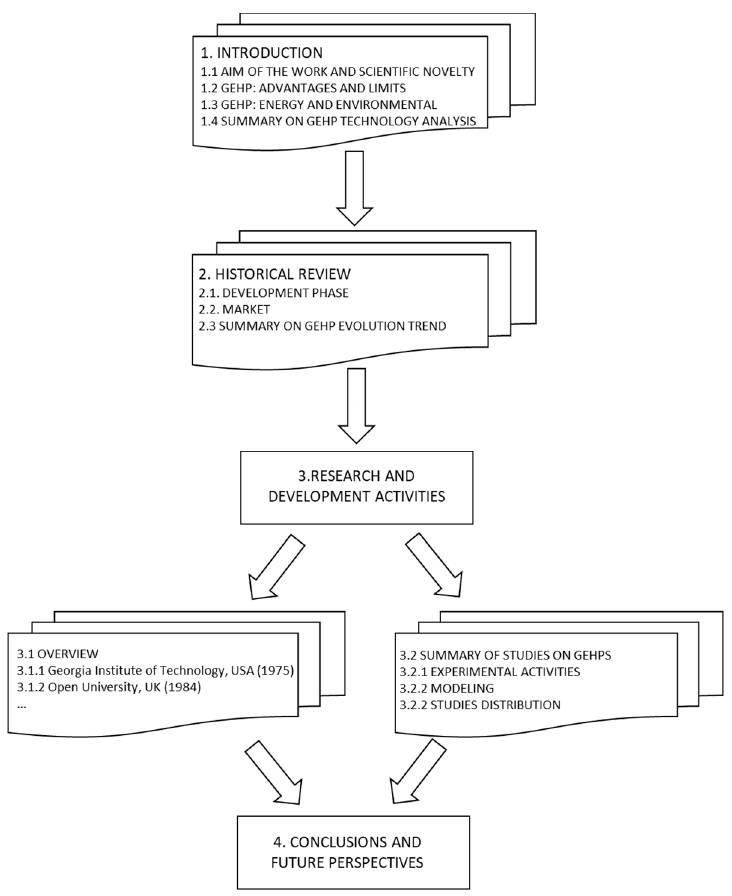
Figure 3. Flowchart followed to conduct the analysis of GEHP.